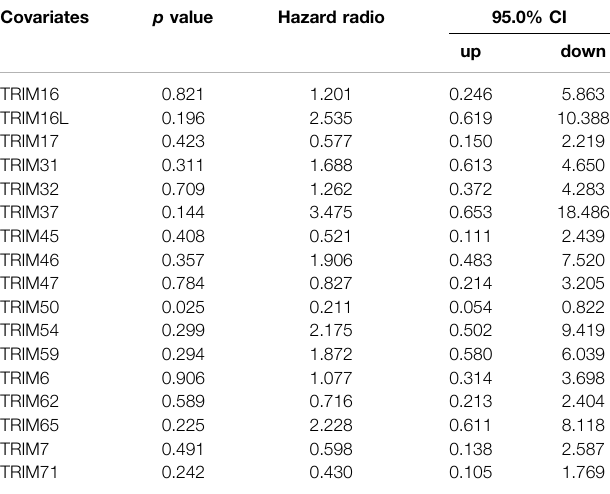
TABLE 1 | The correlation of TRIM genes with the OS of HBV-positive HCC patients dependent on multivariate analysis in TCGA cohort. Covariates p value Hazard radio